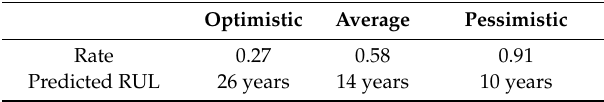
Table 4. Predicted Remaining Useful Life for crude oil